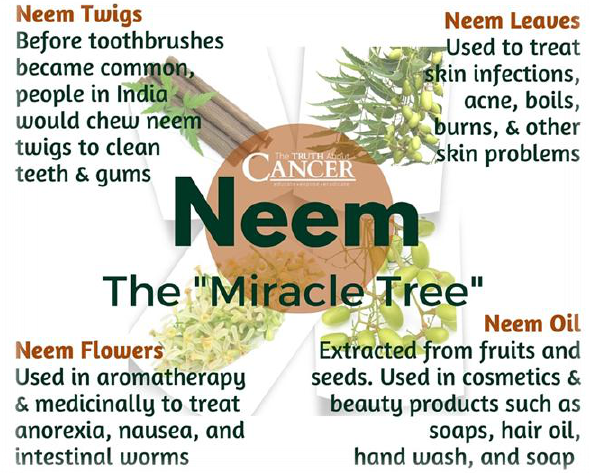
Figure 1: Pharmacological properties of Neem